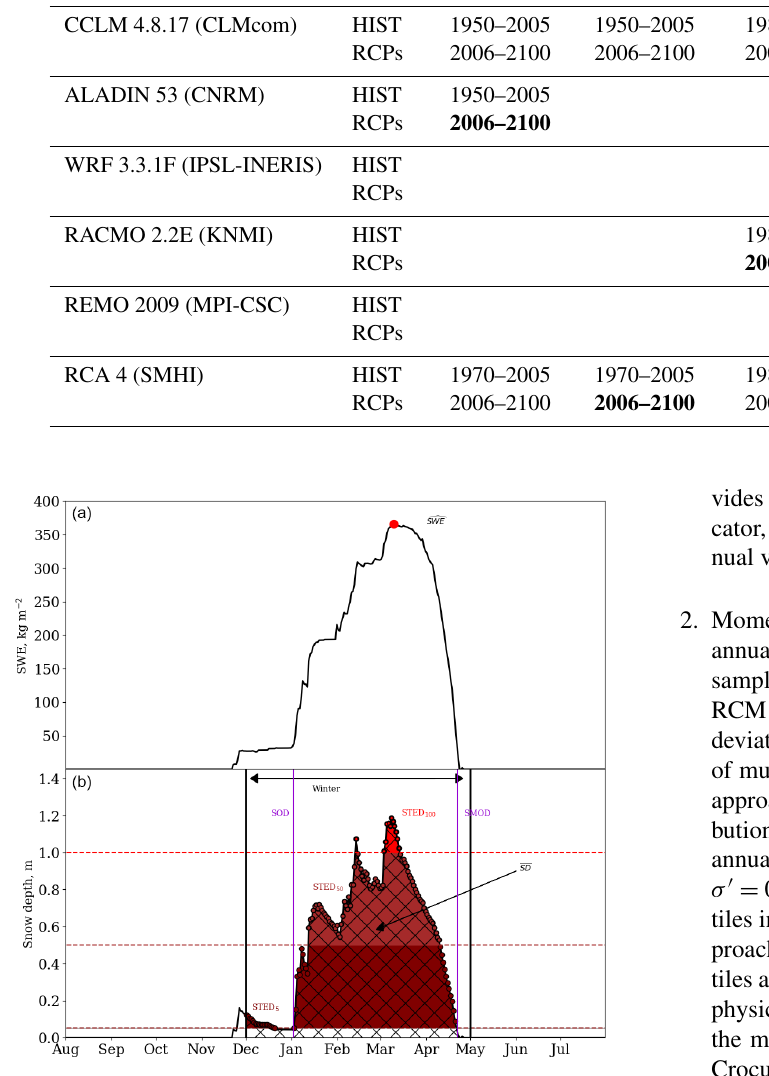
Figure 1. Overview of the snow-related indicators introduced in Sect. 2.5, using an arbitrary SWE and snow depth time series over the course of a given year. (a) SWE time series, displaying the max- imum value (cid:91) SWE. (b) Snow depth time series, displaying graphi- cally the related indicators. See text for